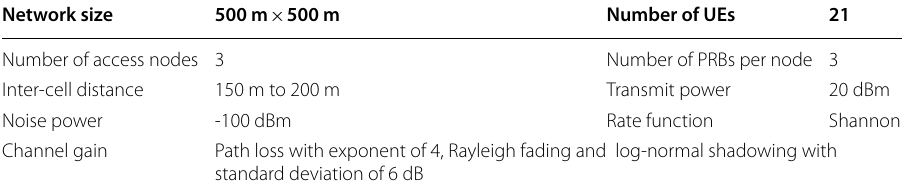
Table 6 Key parameters for simulation setup Network